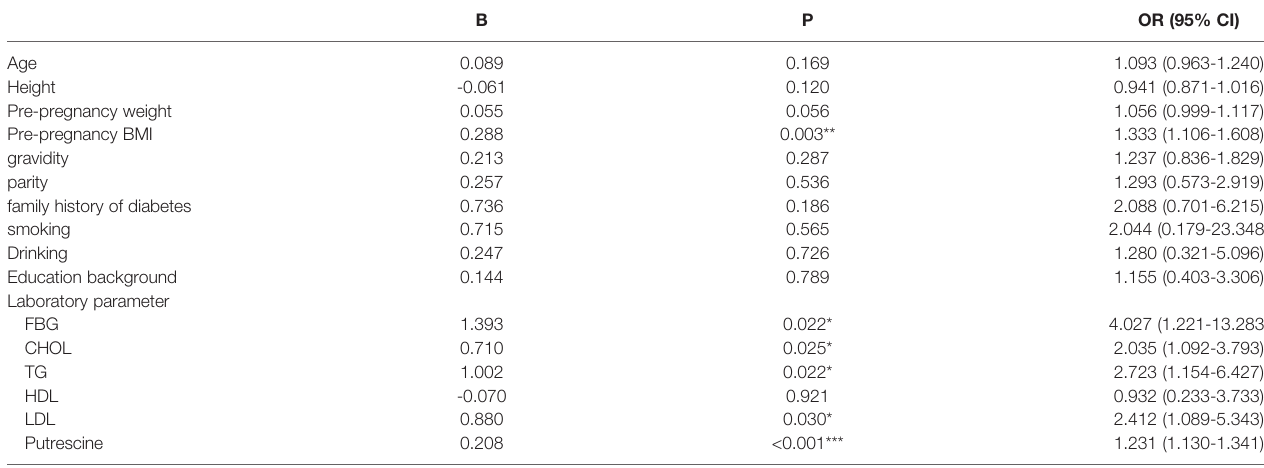
TABLE 3 | Univariate logistic regression for GDM.